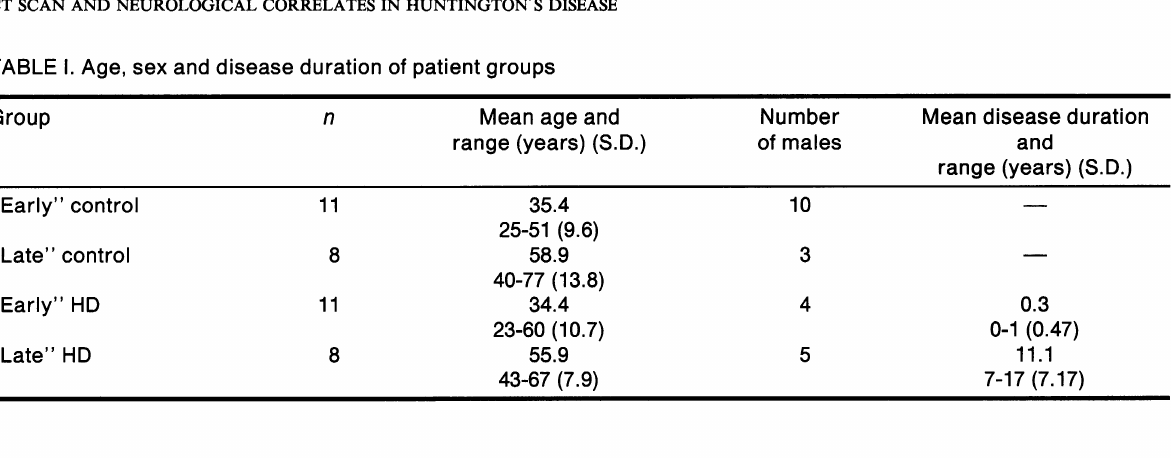
25-51 (9.6) 40-77 (13.8)